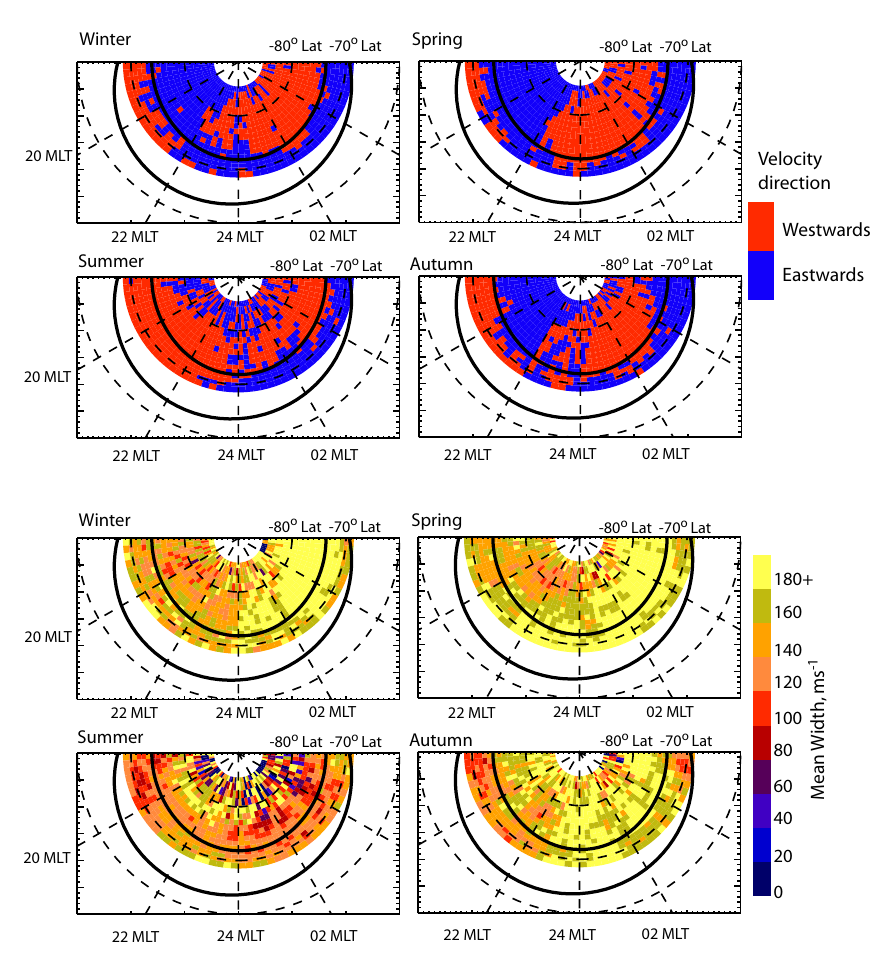
Fig. 9. The top four panels depict the direction of plasma flow observed by the near-azimuthal beams of the Syowa East radar. Red areas show westward moving plasma and blue areas eastward moving plasma. The data are separated into Southern Hemisphere seasons, 15-min MLT intervals and one square for each summary point. A statistical Feldstein oval is overlaid for comparison. The bottom four panels show the similarly separated results for the mean spectral width, again with a statistical oval overlaid.